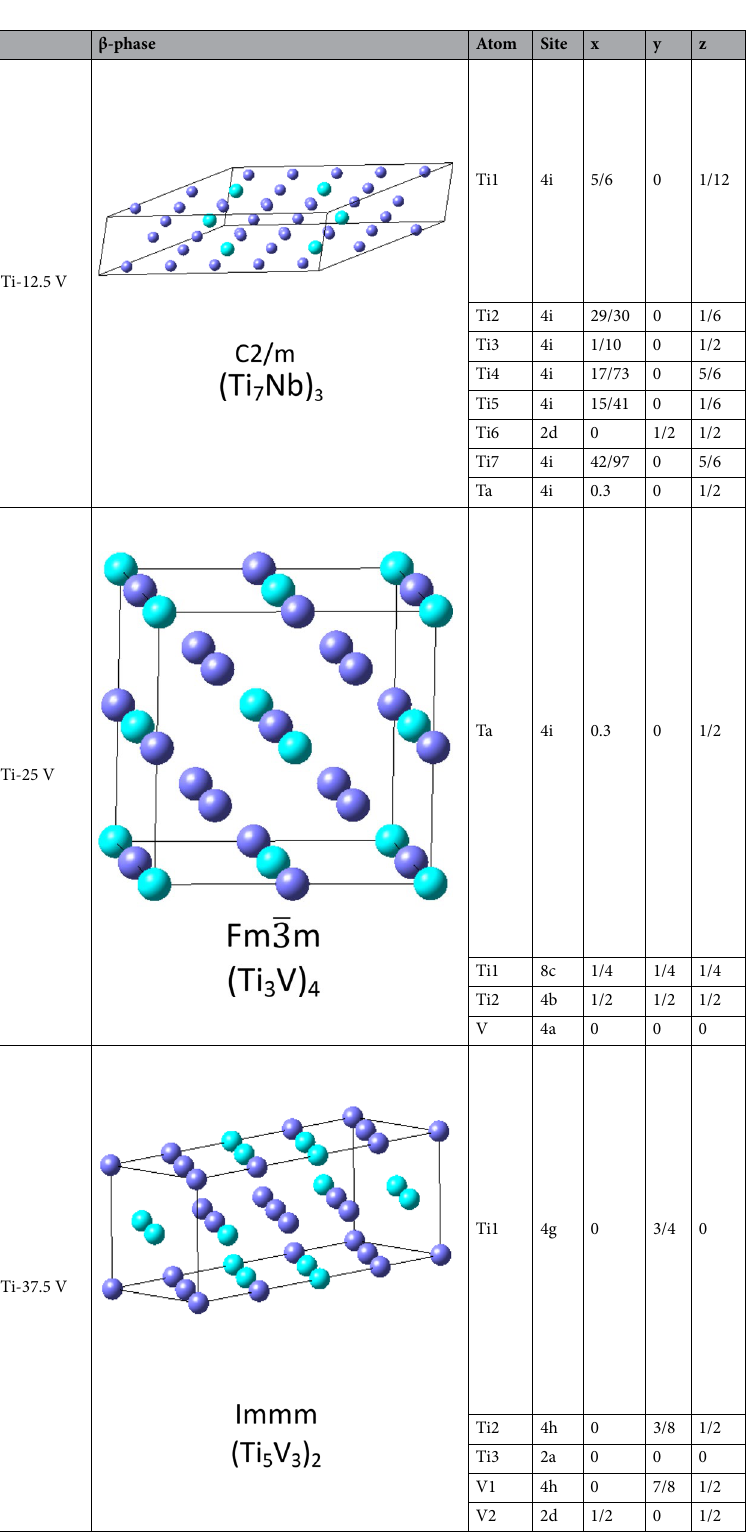
Table 3. CE predictions of stable β-phase structures in the Ti–V binary. The blue and green atoms are respectively Ti and